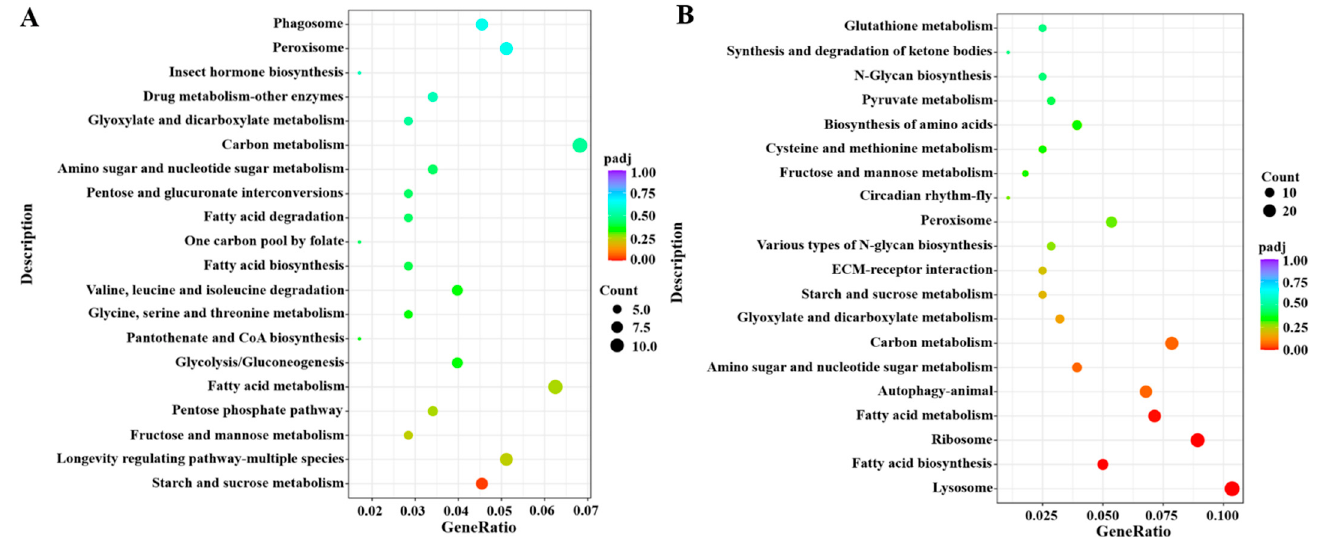
Figure 11. KEGG enrichment analysis of DEGs between ds DcGSK3 groups and ds GFP groups. ( A ) KEGG enrichment analysis of DEGs at 24 h after silencing of DcGSK3 . ( B ) KEGG enrichment analysis of DEGs at 48 h after silencing of DcGSK3 . The sizes of the bubble indicate the number of DEGs enriched to the corresponding term. The color of the bubble indicates the Q value.